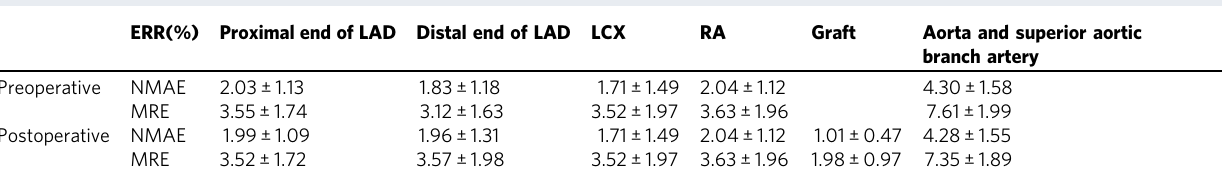
Table 2 Performance evaluation of the pressure fi eld.